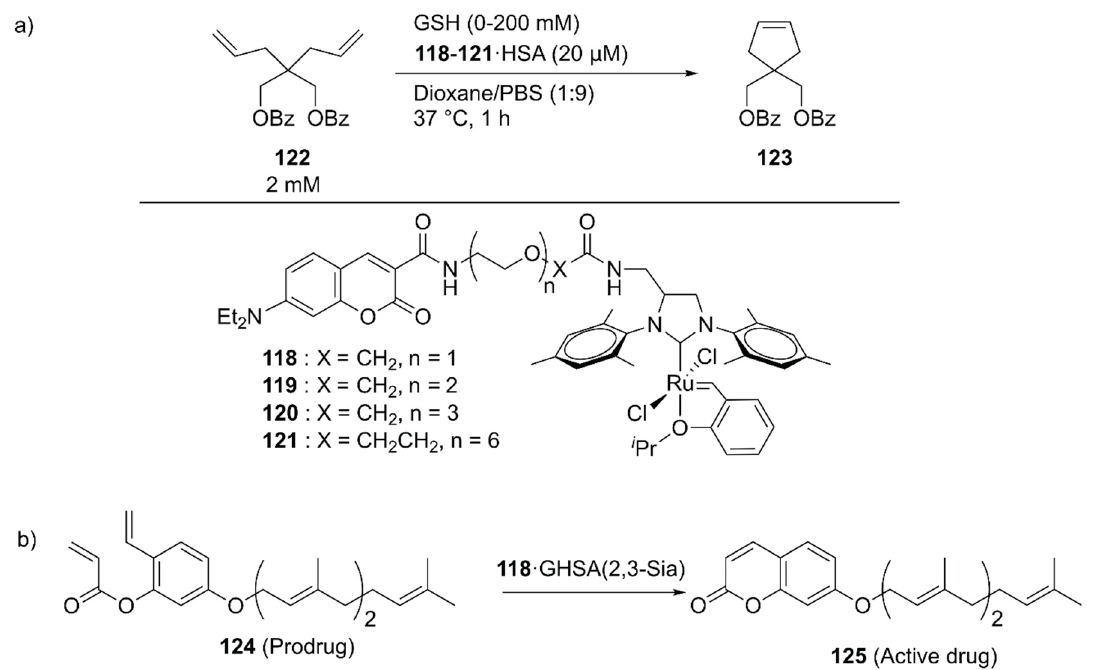
Figure 25. ( a ) RCM reaction catalyzed by GH-type Ru catalysts combined with HSA. ( b ) Prodrug activation by 118 · GHSA(2,3-Sia) generating umbelliprenin 125 . Adapted from [139].